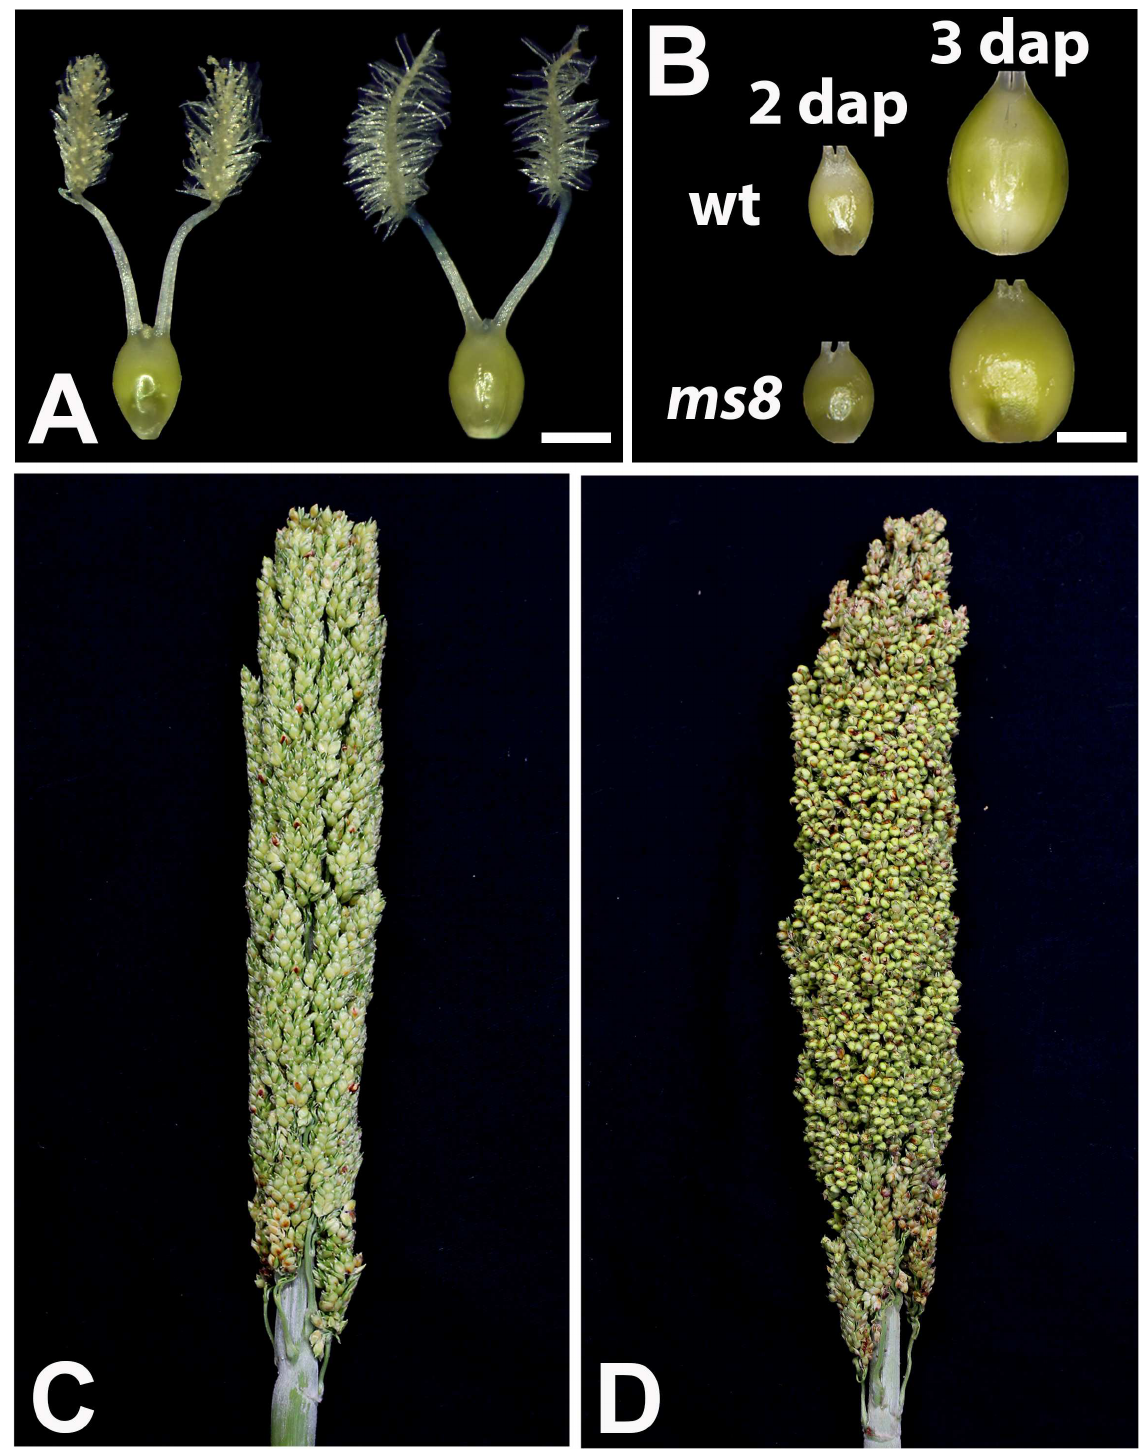
Fig 3. The female fertility is normal in the ms8 mutant. (A) The BTx623 wild-typeovary (left) was the same as that of the ms8 mutant (right) without manual pollination. (B) There was no difference of ovary development betweenBTx623 and the ms8 mutant after manualpollination.dap: days after pollination. Bars = 1 mm in A and B. (C) An ms8 paniclebaggedbefore anthesisshowing no developing seeds. (D) Seeds are being normally developedin a manually pollinated ms8 panicle.